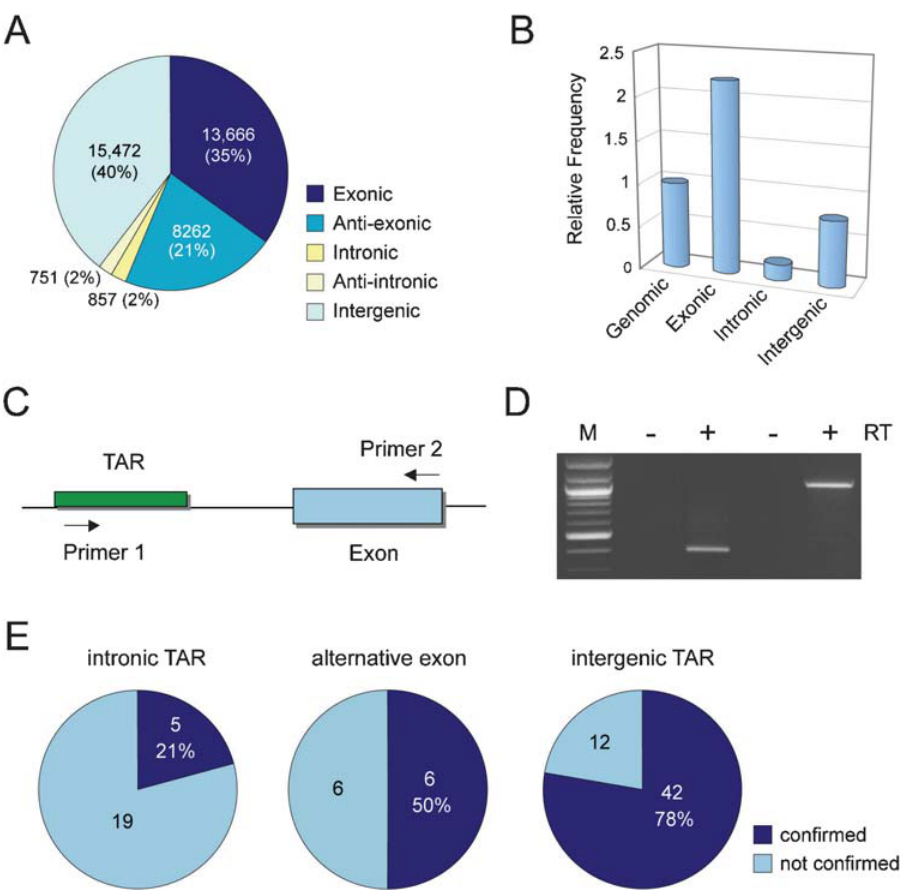
Figure 3. Analysis of non-exonic TARs representing portions of annotated gene models. (A) Number of TARs in different components of the rice genome. (B) Relative frequency of TARs in different genomic compartments. Note that strandedness of the TARs was not considered in this analysis. TAR frequency was calculated as the number of TARs per Mb and normalized to the genomic TAR frequency. (C) The RT-PCR assay to examine whether a gene/TAR pair belongs to the same transcript in which primer pairs target the gene model and the TAR in a convergent fashion. (D) Examples of PCR products amplified in a reverse transcription (RT) dependent manner for the gene/TAR pairs Os10g21310 and Chr10fwd_10366435 (left), and Os02g50070 and Chr2fwd_30528038 (right). (E) Confirmation rates obtained for intronic TARs and proximal intergenic TARs by RT-PCR.